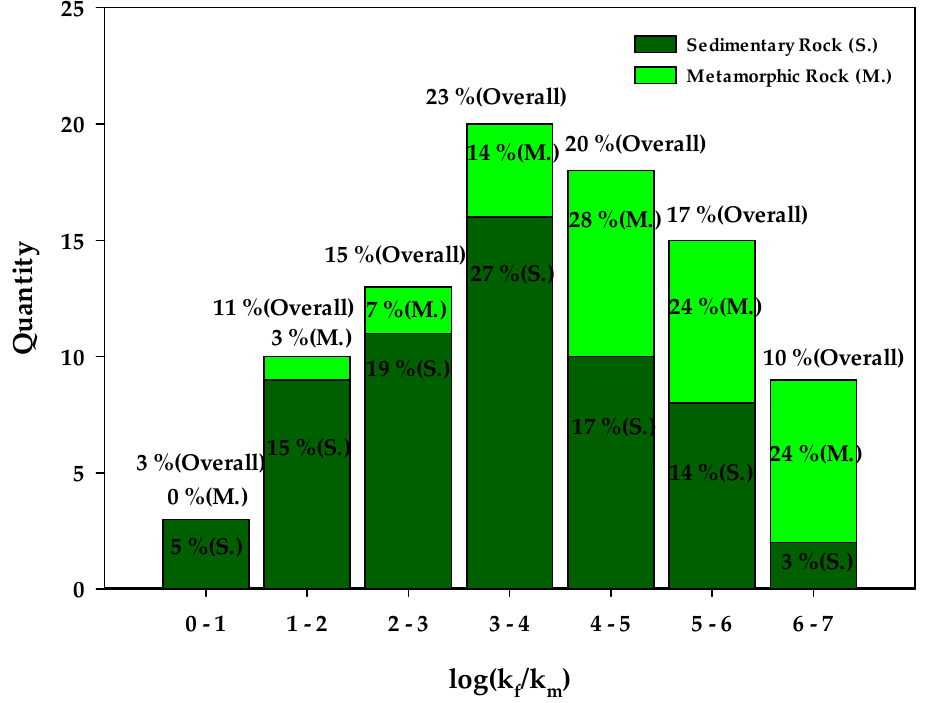
Figure 11. Histogram of log(K f /K m ) for two types of lithology (sedimentary and metamorphic rock).